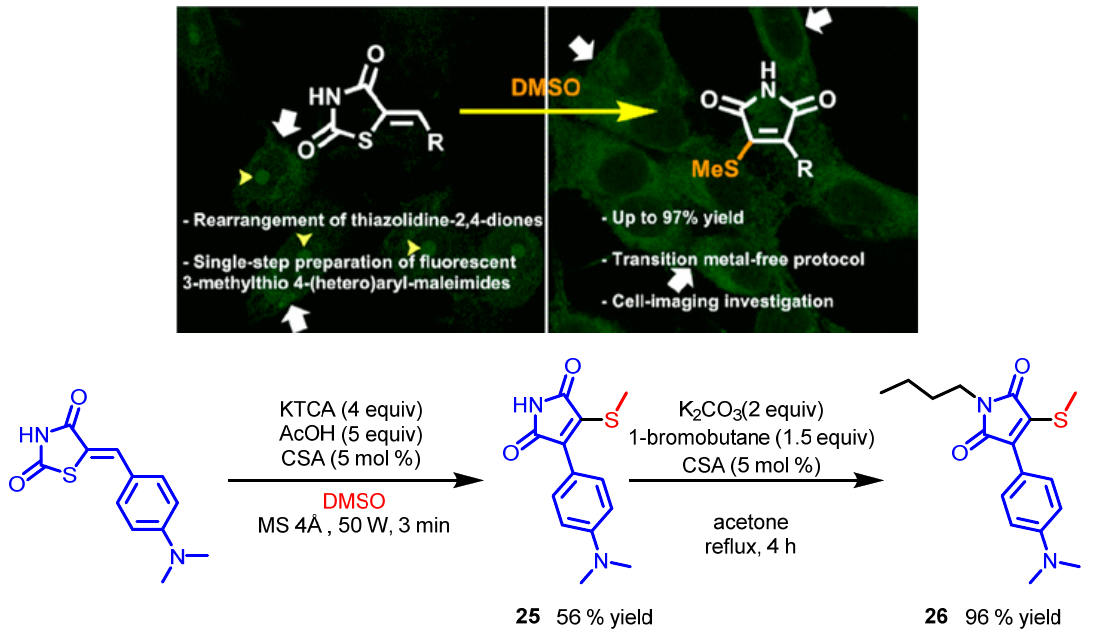
Scheme 21. Top : Summary of 3-methylthio-4-substituted maleimides. Bottom : Synthesis of 3-me- thylthio-4-substituted maleimides 25 and 26 . Adapted from [62].